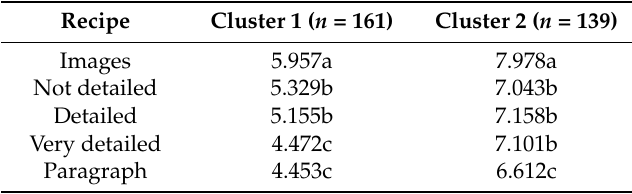
Table A4. ANOVA per cluster, corn